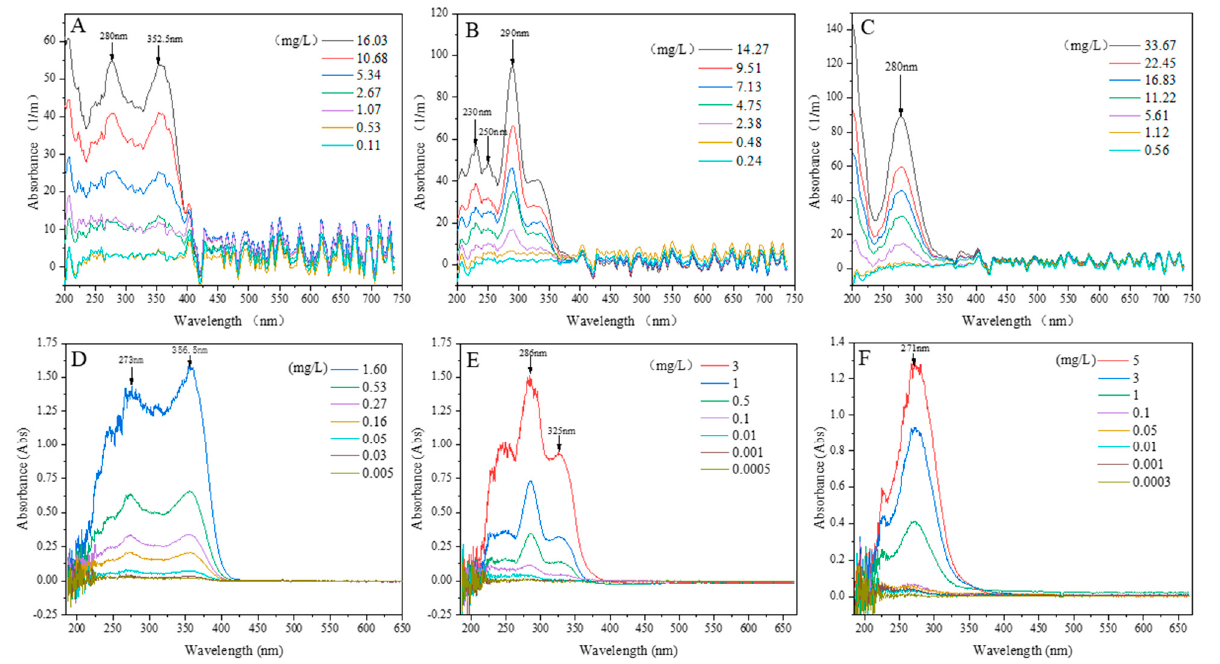
Figure 1. Absorption spectra of ( A ) tetracycline, ( B ) ofloxacin, and ( C ) chloramphenicol by Sensor 1 and ( D ) tetracycline, ( E ) ofloxacin, and ( F ) chloramphenicol by Sensor 2.